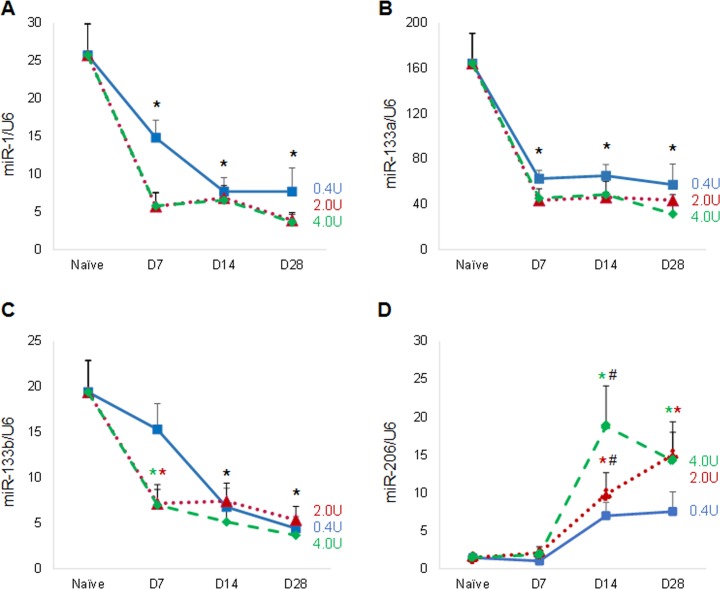
BoNT/A alters muscle miRNA expression.Levels of miR-1 (A), miR-133a (B), miR-133b (C) and miR-206 (D) from naïve and injected quadriceps muscle samples at day 7, 14 and 28 after BoNT/A treatment (n = 3-10/group) were assessed. Results from dosage groups of 0.4 (denoted with blue solid line), 2.0 (red dotted line) and 4.0 (green dashed line) U/100g body weight are shown. Expression was quantitated relative to levels of the small nuclear RNA U6. (* p<0.05 vs. naïve; # p<0.05 vs. 0.4U dose).